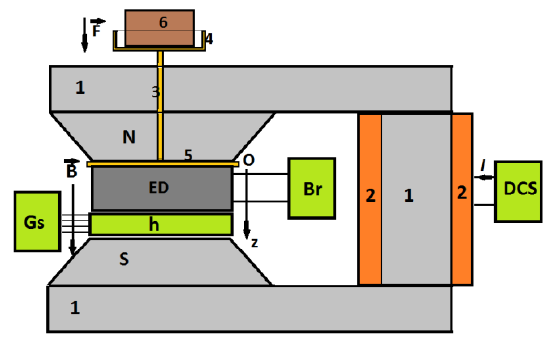
Figure 5. Overall setup. 1 — magnetic core, 2 — coil, 3 — non-magnetic spindle, 4 — non-magnetic plate, 5 — the non-magnetic disk, 6 — non-magnetic marked masses, N and S — magnetic poles, ED — electric device, Br — RLC bridge, Gs — gaussmeter, h — Hall probe, DCS — continuous source current, Oz — coordinate axis, B — magnetic flux density vector, F — force vector, I — the intensity of the electrical